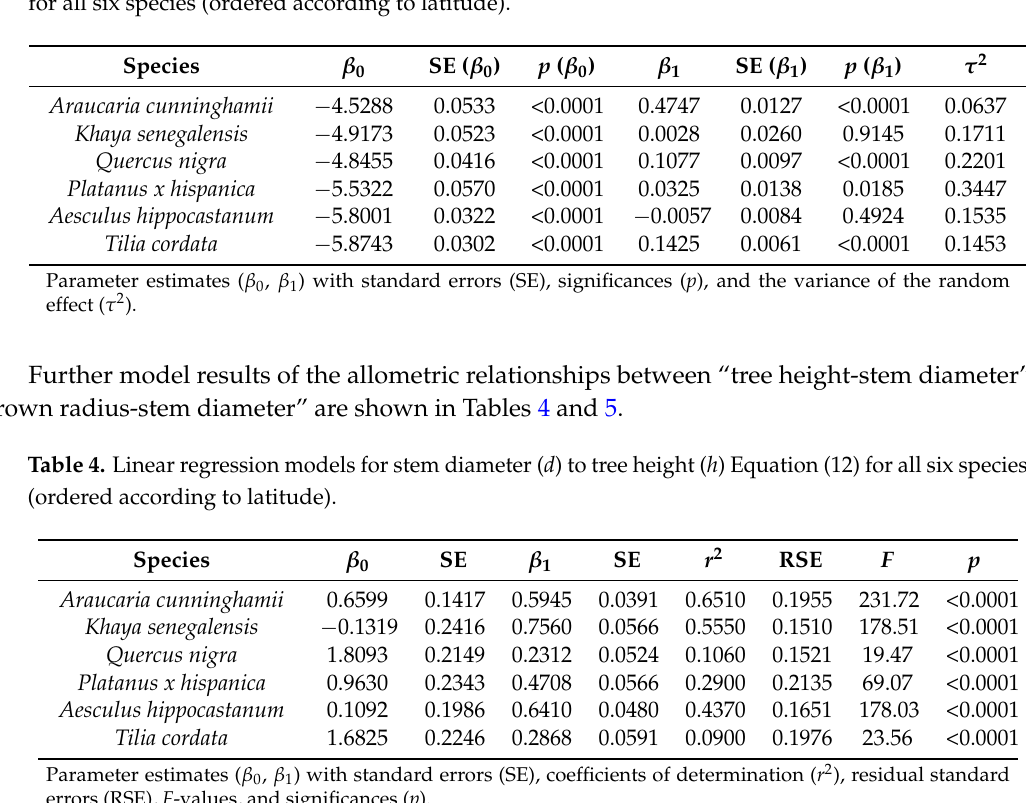
Table 3. Linear regression models for the basal area to basal area increment allometry (Equation (5)) for all six species (ordered according to latitude).